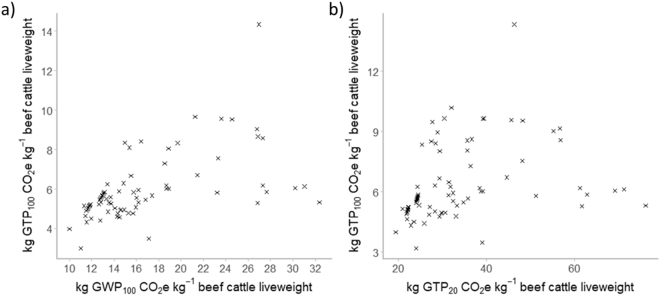
Relationships between a) GWP100 and GTP100 (rτ = 0.48, p < 0.001) and b) GTP20 and GTP100 (rτ = 0.39, p < 0.001) CO2e footprints per kg beef cattle liveweight.